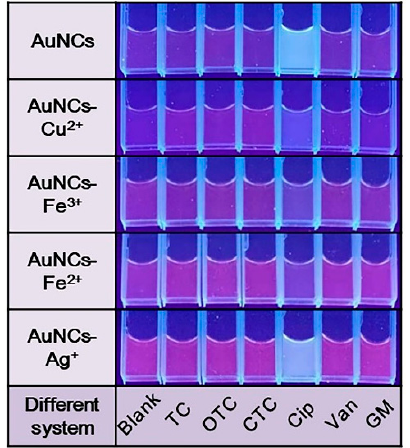
Figure 3. Photographs of the color change of 6 antibiotics in different AuNCs-metal ions systems under UV light (302 nm). Reaction conditions: AuNCs, 0.25 mg mL − 1 ; metal ions, 10 µ M; antibiotics, 15 µ M.